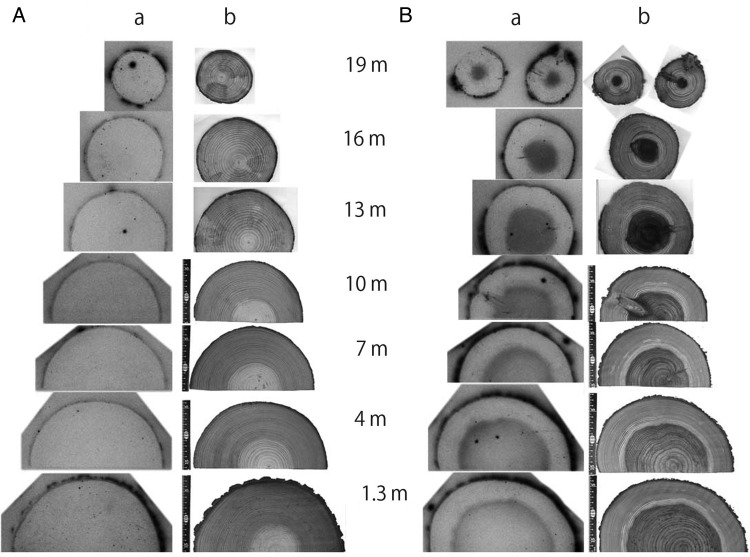
Autoradiography of trees in the forest [1,2]: (A) pine tree (Pinus dinsiflora) and (B) sugi (Cryptomeria japonica). The height of the sugi and pine tree were 23.2 m and 22.2 m, respectively. Wood disks were harvested from 1.3 m, 4.0 m, 7.0 m, 10 m, 13 m, 16 m and 19 m above the surface of the soil, and an autoradiograph of each disk was taken by an imaging plate: (a) autoradiograph and (b) photograph. The radioactivity of the wood disks was high at the surface of the bark in both trees. In the case of sugi (B), a large amount of radioactive Cs was transferred into the heartwood, especially higher in the tree. However, in the case of the pine tree (A), most of the radioactive cesium was found to be at the surface of the trunk (S. Masumori, T. Tange et al.).